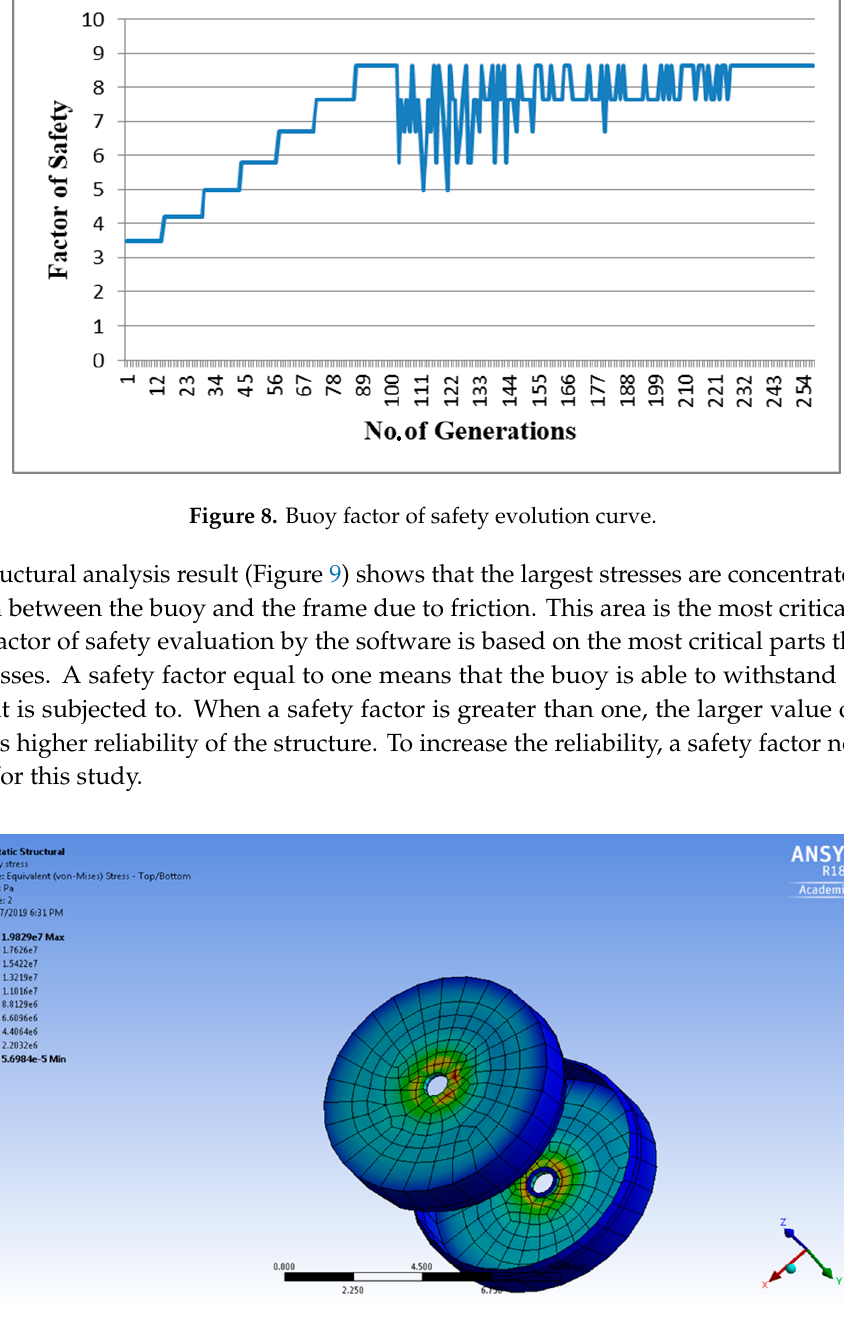
Figure 9. Extract from ANSYS showing stress distribution on buoy.